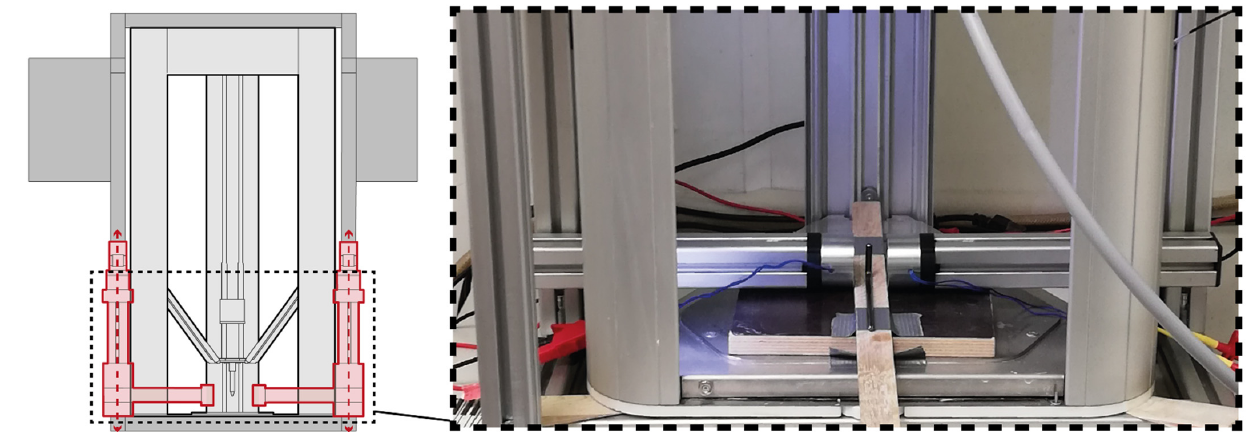
Figure 7. Detail of the structure of the additional module for case study 4.1.